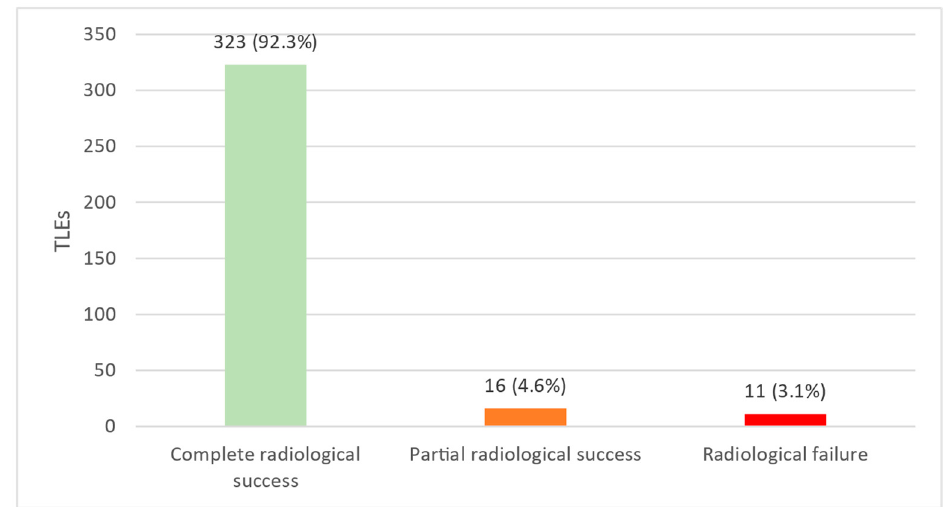
Figure 2. Radiological success or failure following transvenous lead extraction. Out of 350 TLE performed (100%), 323 TLE (92.3%) resulted in complete radiological success, 16 TLE (4.6%) resulted in partial radiological success, and 11 TLE (3.1%) resulted in radiological failure. TLE: transvenous lead extraction.